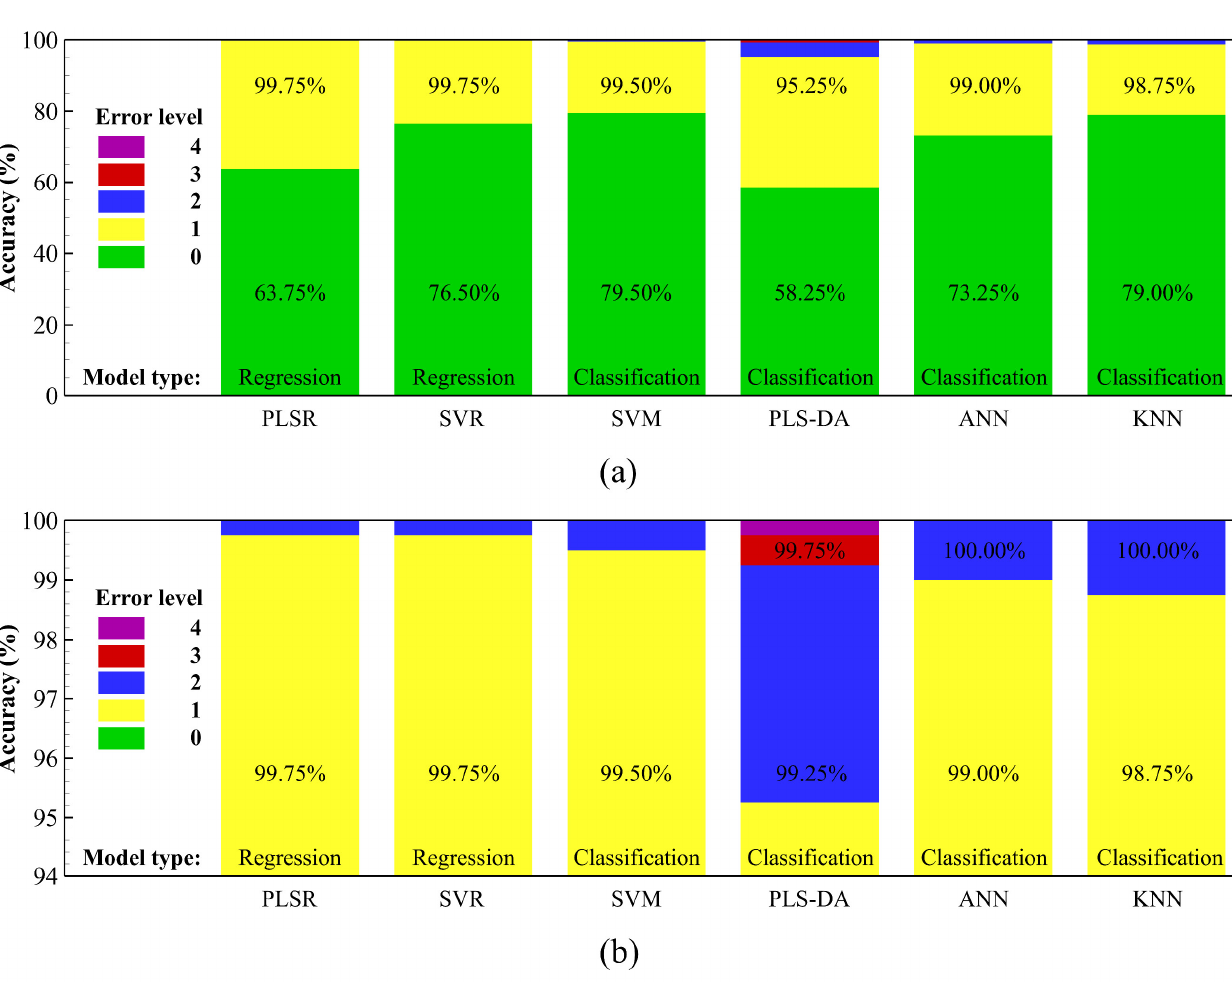
Figure 5. ( a ) The exact accuracy and n-level-error accuracy of the six ripeness evaluation models using pixel-based prediction and majority rule and ( b ) the close-up of prediction accuracy.